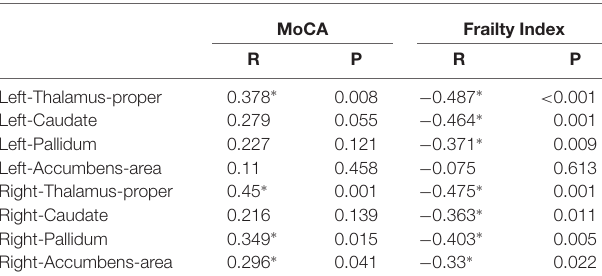
TABLE 4 | Correlation of between the volumes of subcortical nuclei and MoCA, frailty index scores.